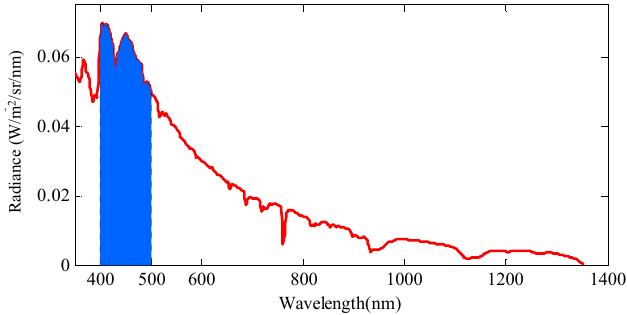
Figure 3. The spectral radiance curve of the clear skylight measured with an analytical spectral device (ASD). The field-of-view (FOV) of the ASD is 25°. The measurement was carried out at 8:10 (UTC) on 30 May 2013 in Beijing, China. The zenith area of skylight was detected while the solar zenith angle was about 53°.